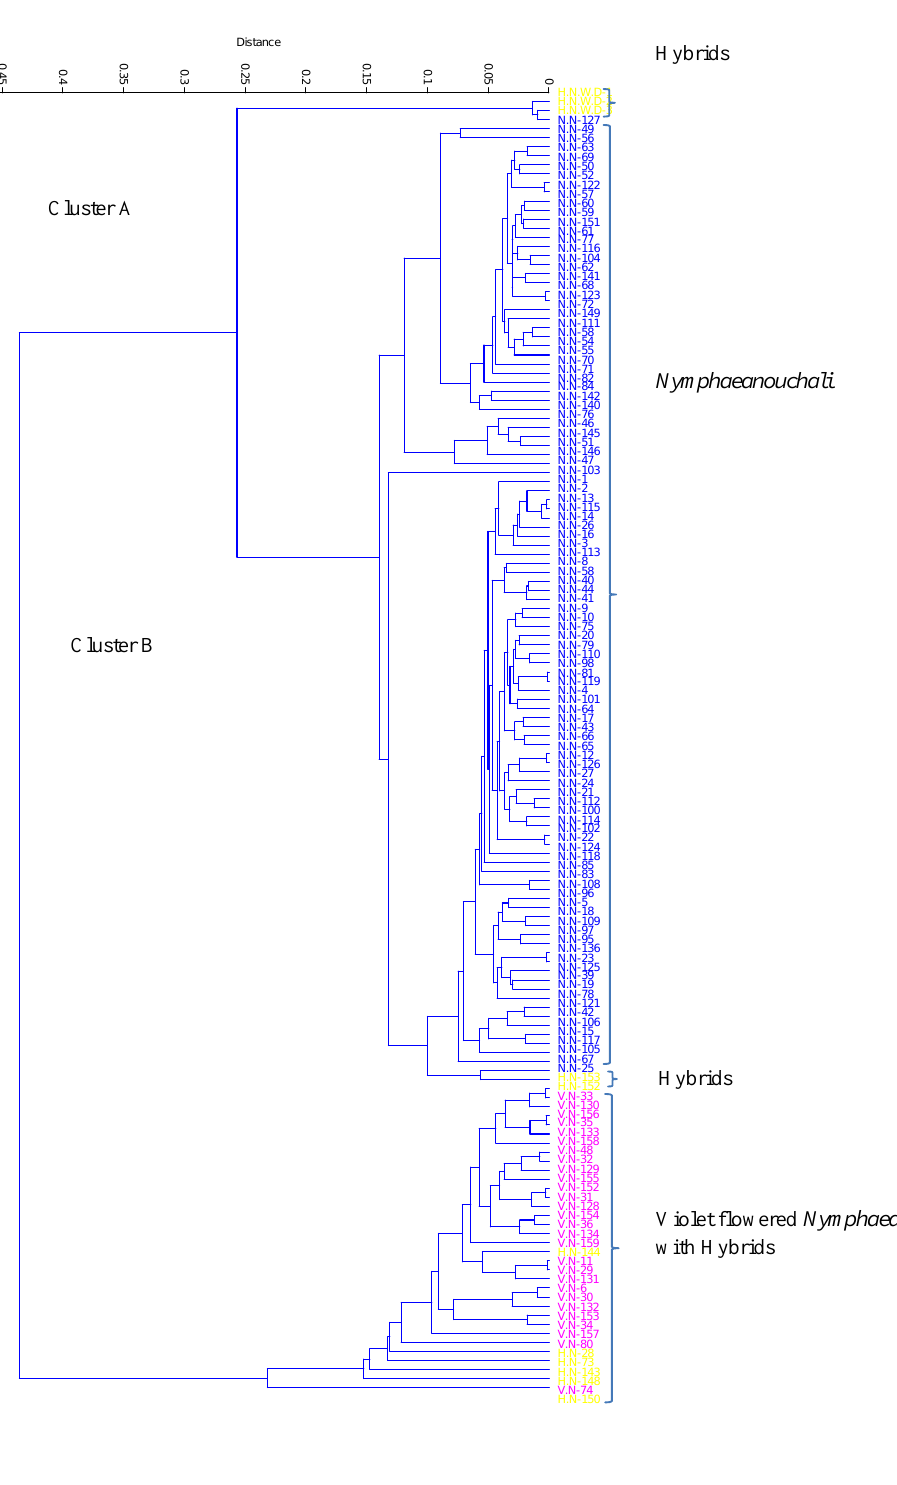
Figure 3: The dendrogram produced from the multivariate analysis of morphological characters for the pure populations of tentative parents and hybrids of Nymphaea